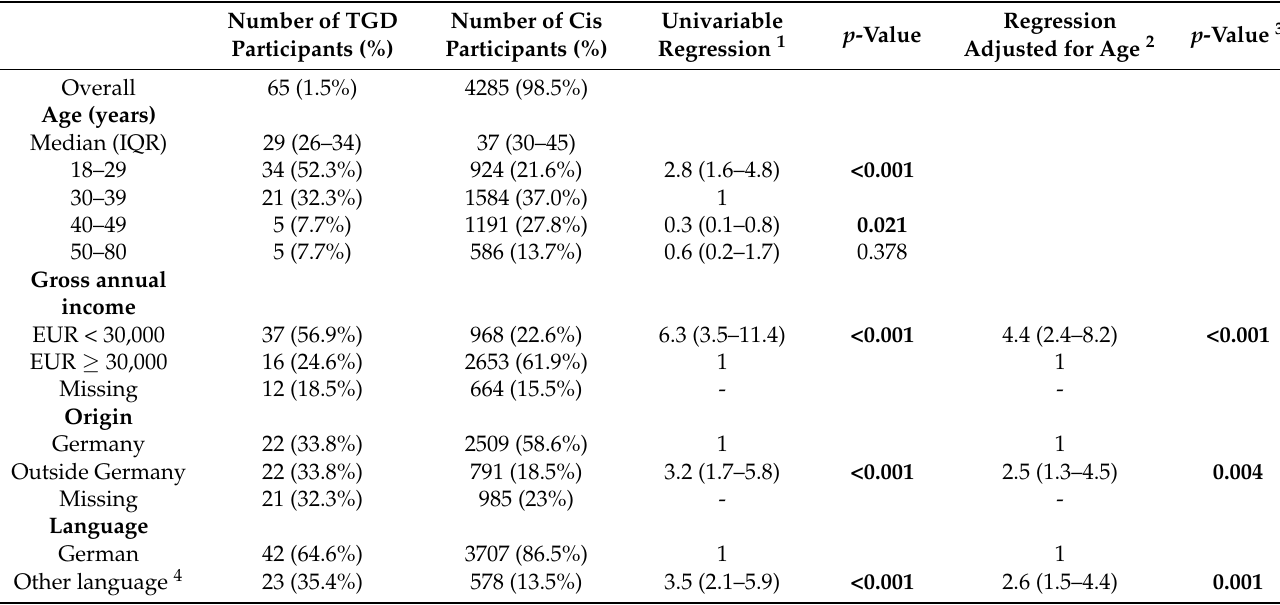
Table 1. Demographic data of trans and gender diverse (TGD) and cis male pre-exposure prophylaxis (PrEP) users ( n = 4350): Results of univariable and multivariable